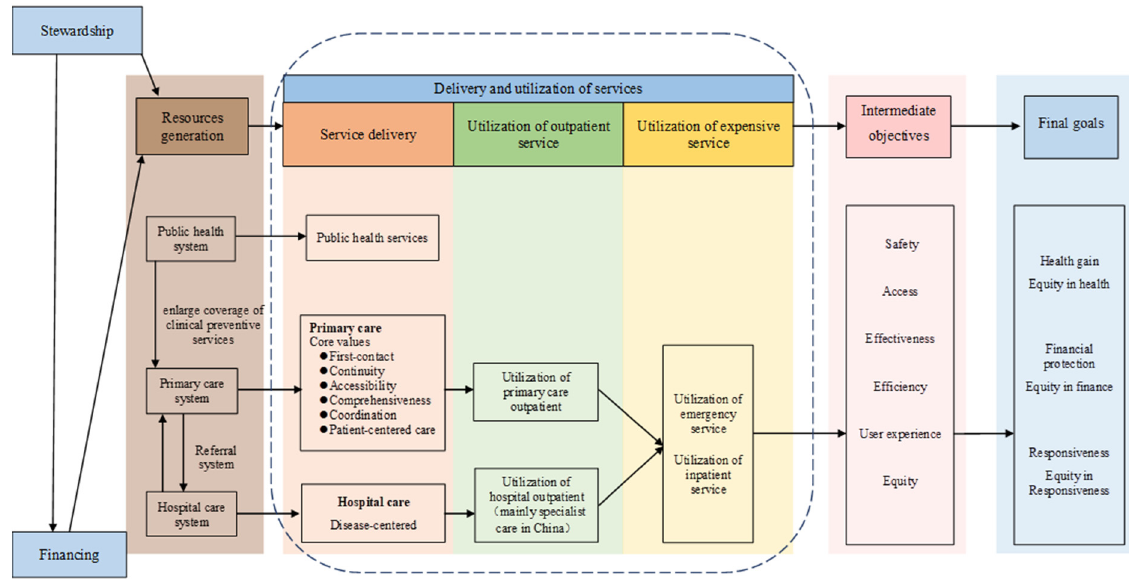
Figure 1. The assessment framework.